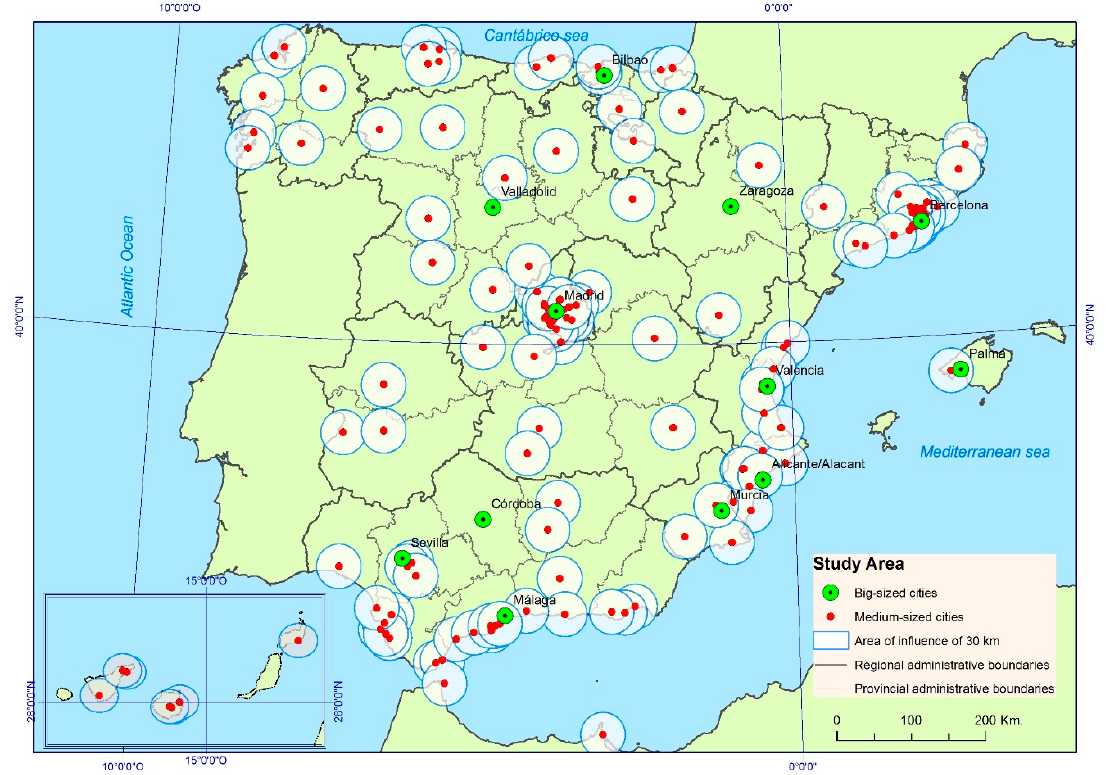
Figure 1. Map with medium-sized urban areas and cities of Spain. Source: CNIG [57], INE [55] and own elaboration.